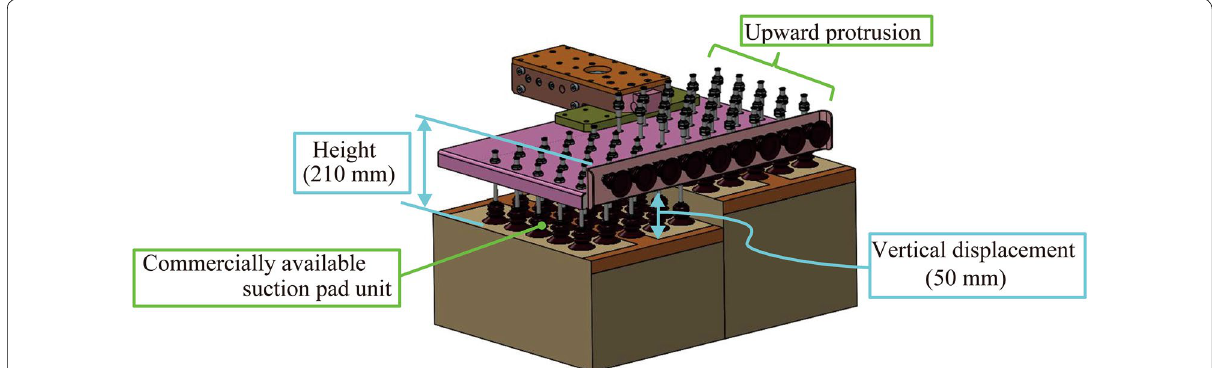
Fig. 7 Three-dimensional diagram of a conventional end